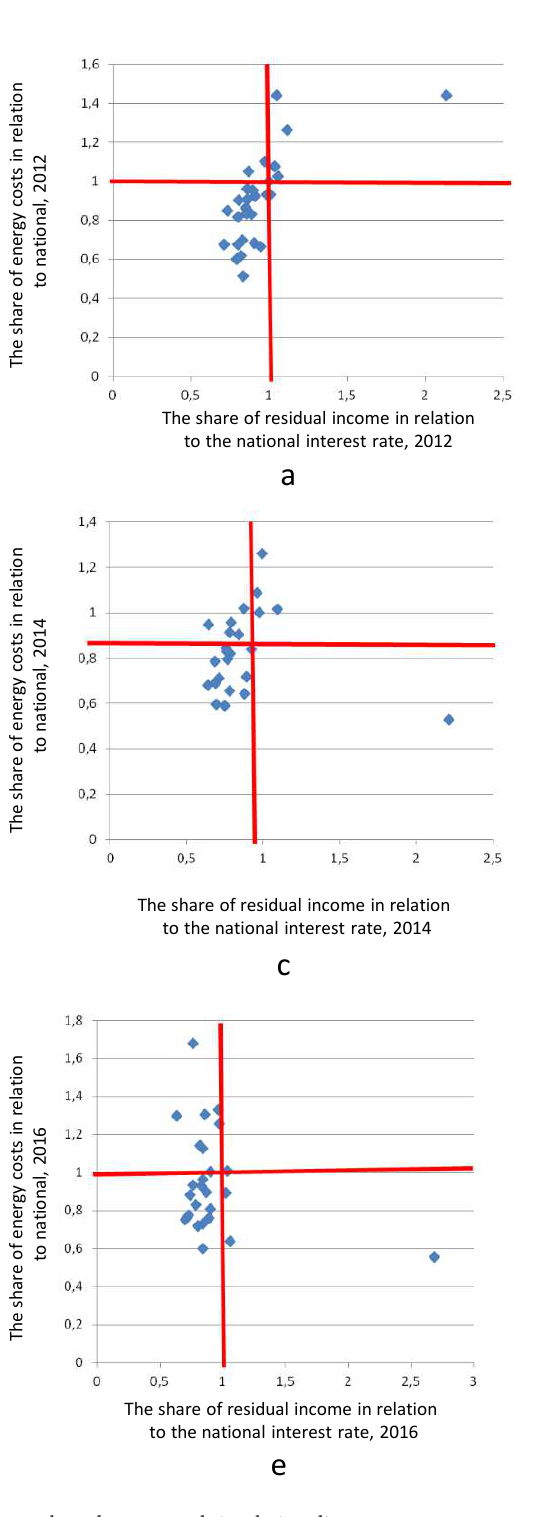
Figure 3. The “fuel poverty” modeling outcomes for Ukraine’s regions as a result of measuring the residual household income after subtracting fuel and upkeep costs and comparing it to the poverty threshold, which is mainly 60% of the average national income after subtracting fuel and upkeep costs: a, b, c, d, e – annual simulation